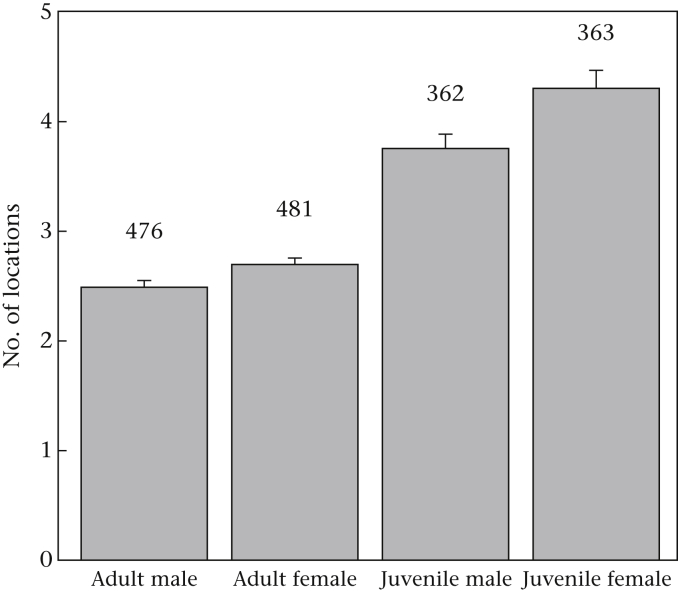
The average number of locations per year where individuals of the different age and sex classes were observed foraging. Lines show SEs and data are used from three winter seasons. Numbers show the number of unique individuals recorded in each class.